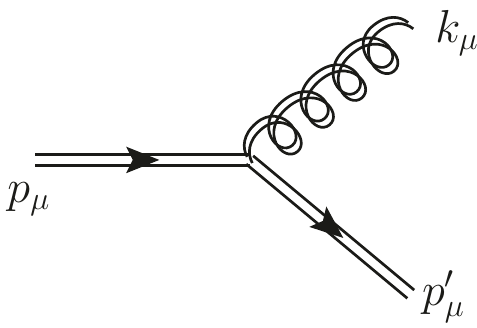
Figure 1 . Tree-level non-linear Compton scattering on a plane wave background. Double lines indicate that the particles are fully dressed by the plane wave: in vacuum, the corresponding amplitudes would vanish by momentum conservation, but here they are nontrivial functions of the scattering momenta and the